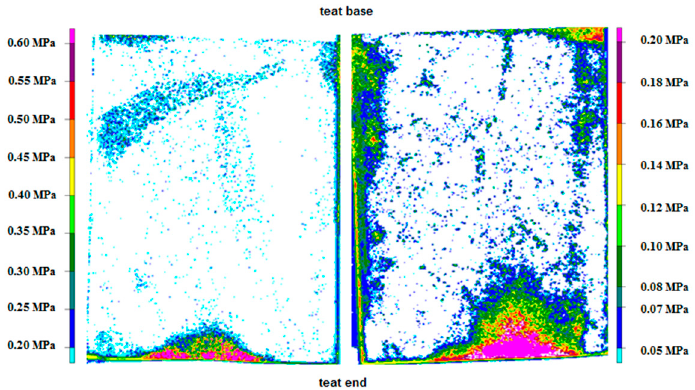
Figure 3. Pressure levels and pressure distribution on a plastic teat caused by the collapsing liner measured with Film 1 ( left ) and Film 2 ( right ).